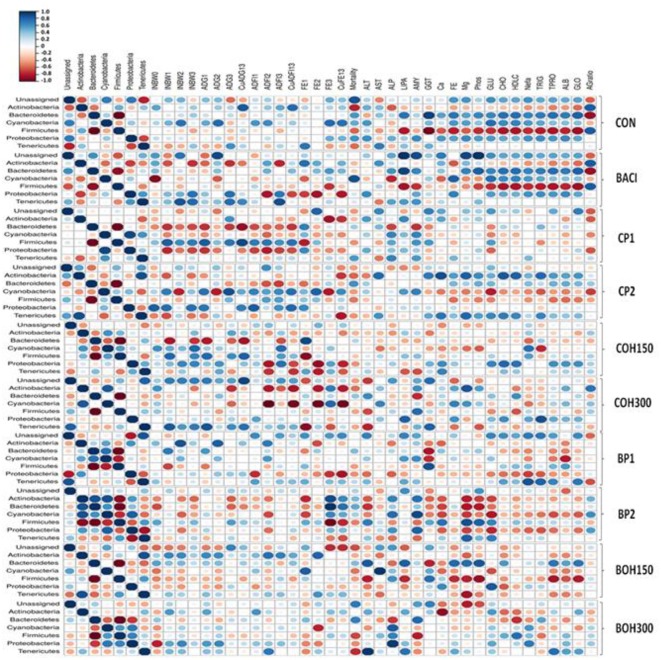
Spearman non-parametric rank correlations among bacterial phyla, performances [individual body weight (INBW), average daily gain (ADG), average daily feed intake (ADFI), feed efficiency (FE) in the starter, grower, and finisher phases as well as during the overall raising period (cumulative)]; mortality; and different blood metabolites: enzymes, minerals, glucose, lipids, and protein. The scale colors indicate whether the correlation is positive (closer to +1, blue circles) or negative (closer to −1, red circles) between the taxa (phylum), performances and the blood metabolites. All correlations presented were statistically significant (P < 0.05). Large and small circles indicate strong and weak correlations, respectively.